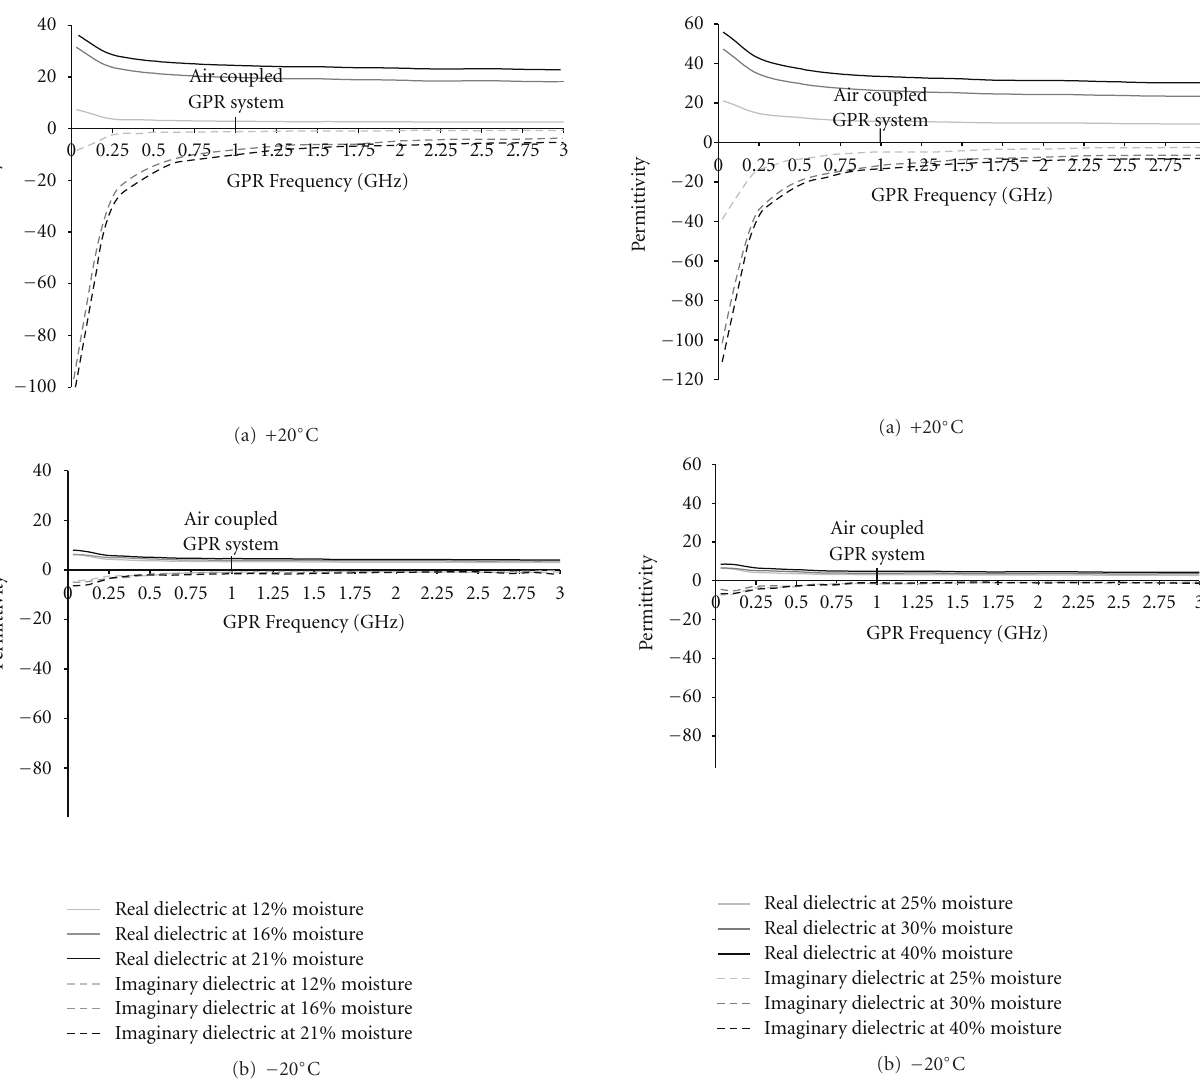
Figure 8: Complex dielectric network analyzer results of high plastic lacustrine